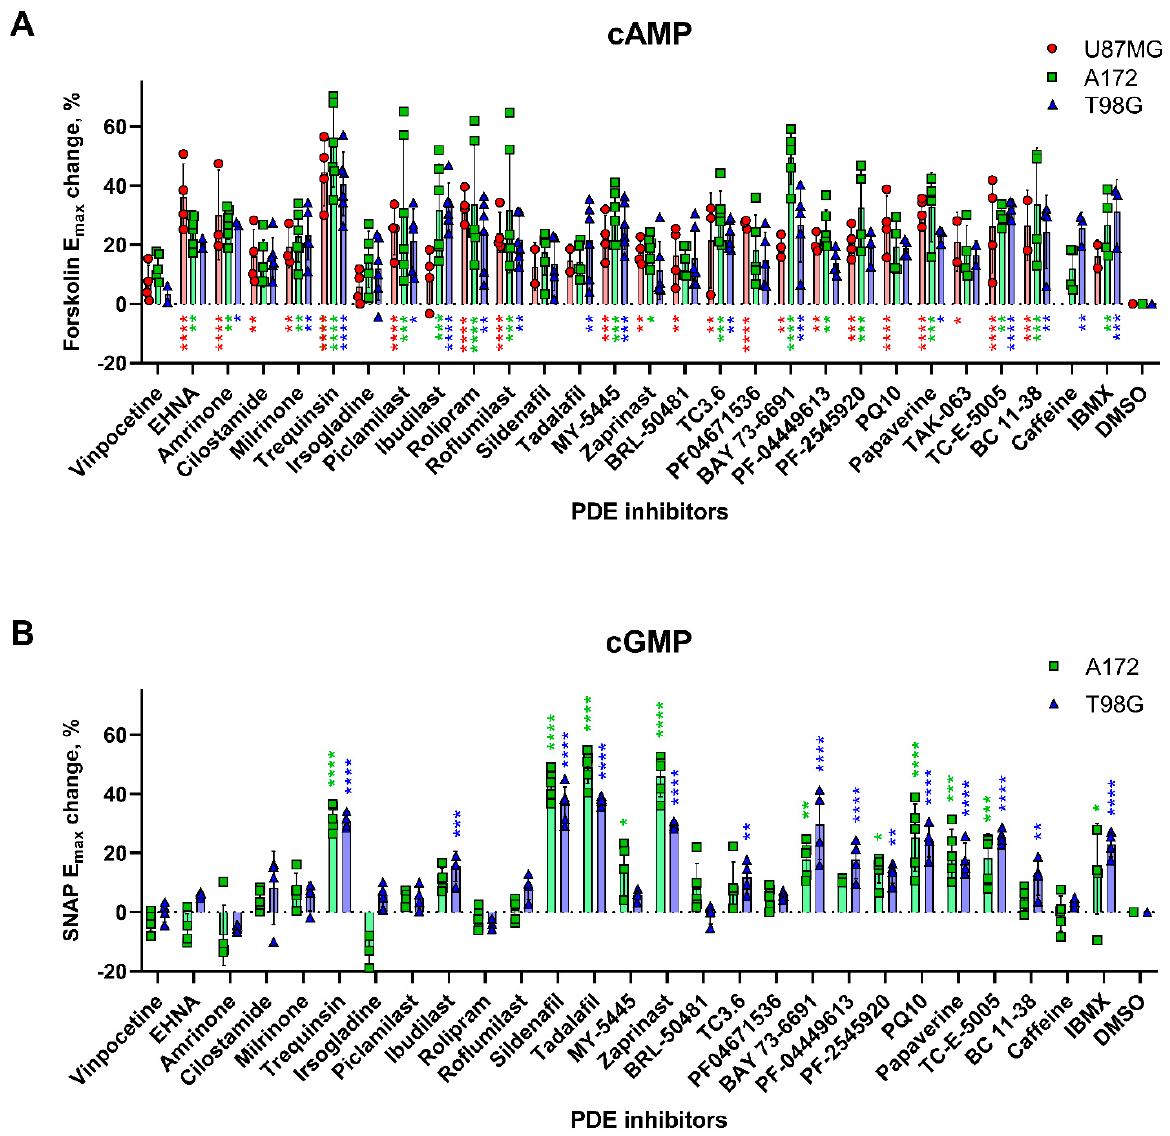
Figure 3. Effects of PDE inhibitors on cAMP and cGMP levels in glioblastoma cell lines. Incubation of glioblastoma cell lines with PDE inhibitors at a concentration of 100 µ M altered cAMP ( A ) and cGMP ( B ) signals evoked, respectively, by 1 µ M forskolin and 100 µ M SNAP. Fractional changes are presented as the mean ± standard deviation of 4–6 independent experiments. The statistical significance of induced changes is indicated as follows: * p < 0.05; ** p < 0.01, *** p < 0.001, **** p < 0.0001.